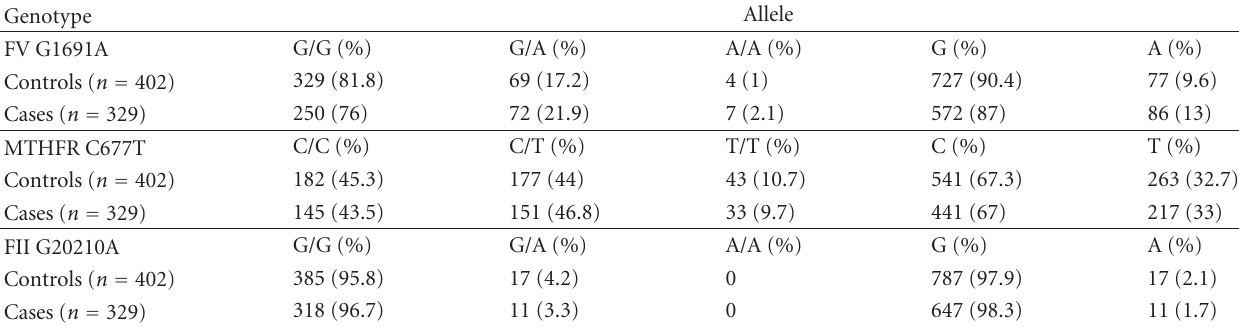
Table 4: Genotype and allele analysis of factor V Leiden G1691A, MTHFR C677T, and prothrombin (FII)